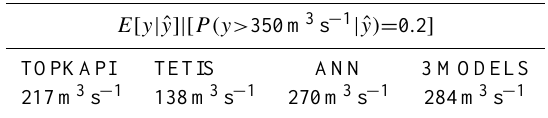
Table 2. Expected value of prediction corresponding to the proba- bility of 20% that the true value will exceed the 350m 3 s − 1 thresh- old, computed for each model and their Bayesian